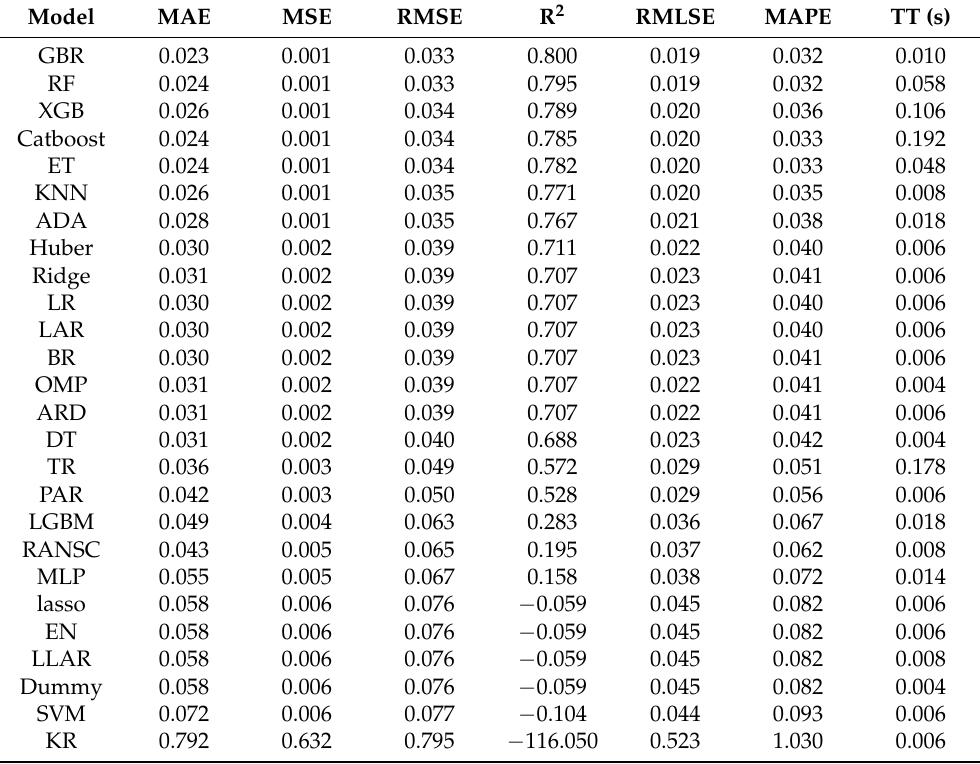
Table 9. Accuracy assessment of different estimation models based on RGB vegetation indices.